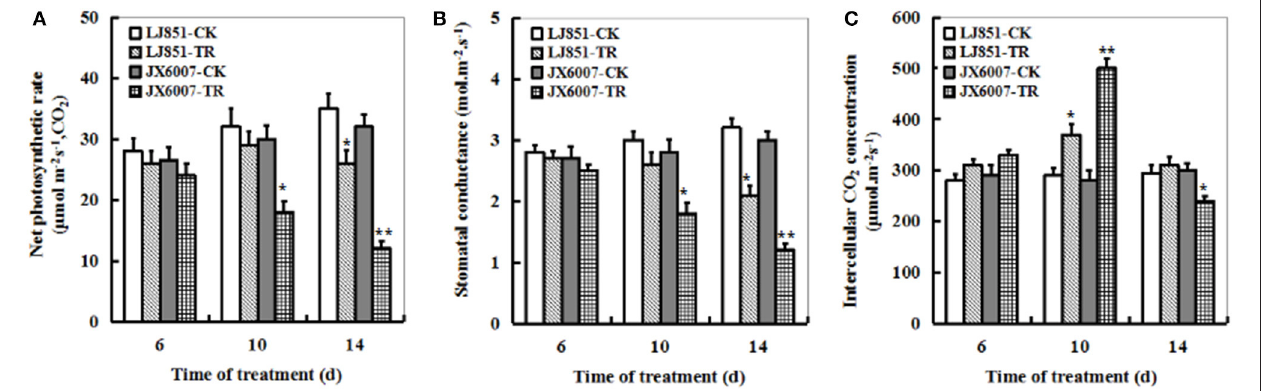
FIGURE 5 | Dynamic changes of photosynthetic parameters in both types of tobacco plants during 14 days of drought stress. (A) Net photosynthetic rate; (B) Stomatal conductance; (C) Intercellular CO 2 concentration. LJ851-CK stands for LJ851 under control conditions; LJ851-TR stands for LJ851 under drought conditions; JX6007-CK stands for JX6007 under control conditions; JX6007-TR stands for JX6007 under drought conditions. Data are means ± SE calculated from three replicates. Bar indicates SE. * t -test, with P < 0.05; ** t -test, with P <